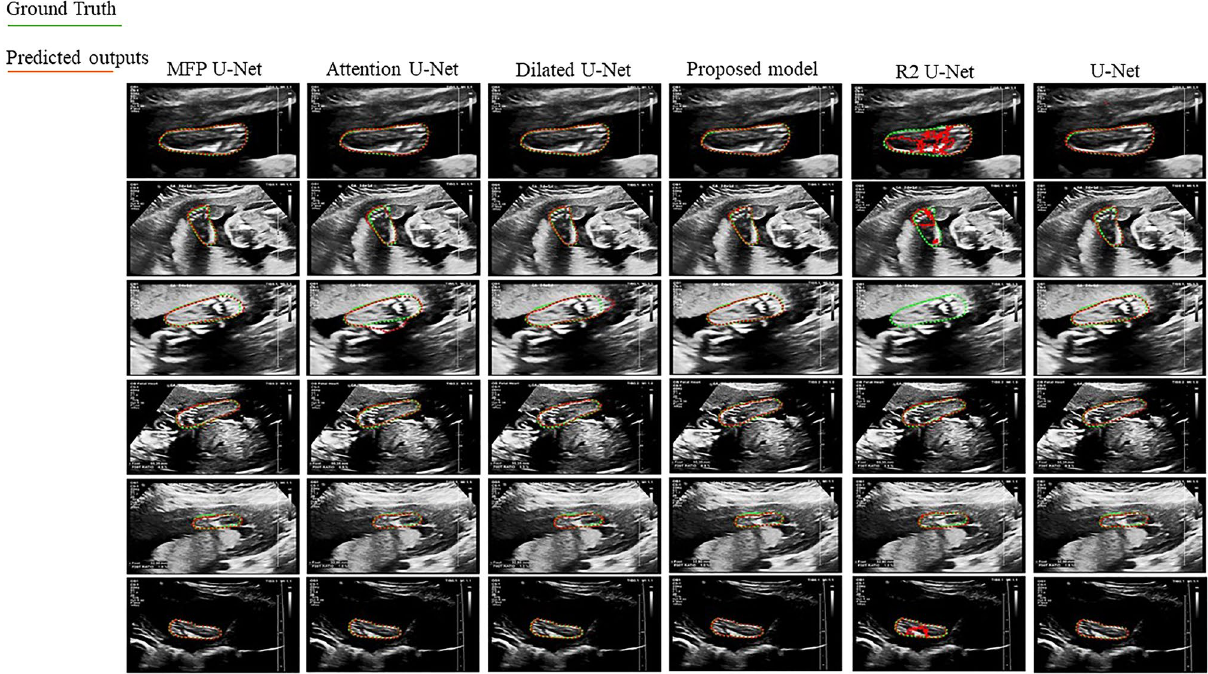
Figure 10. Representative results of fetal foot segmentation achieved by the proposed model in comparison with other U-Net based models.